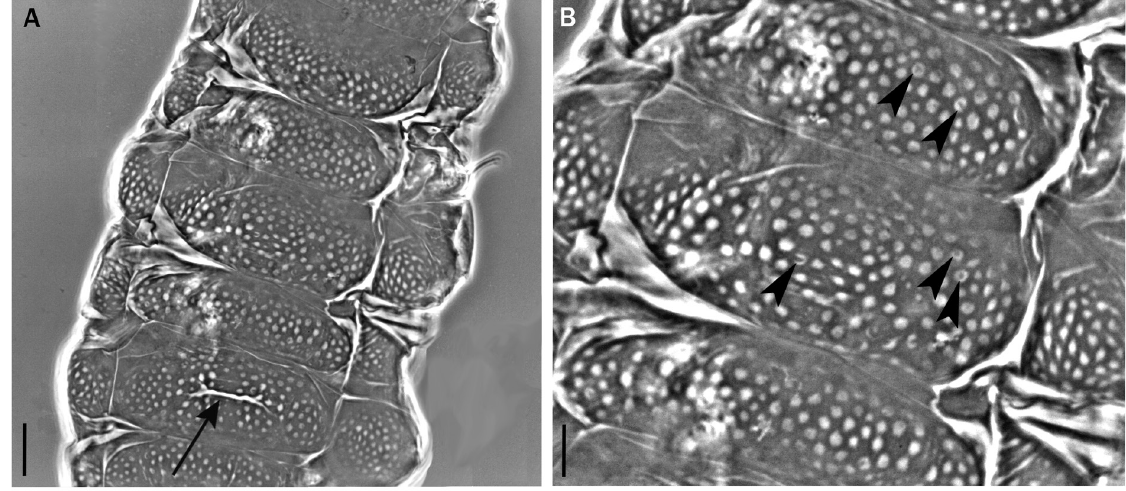
Fig. 6. Milnesium pelufforum sp. nov., paratype, young (slide No. 5898 (Pilato and Binda Collection)). Details of the cuticular ornamentation. A . General view of the dorsal cuticle showing several bands of sculptured cuticle and the cuticular groove at the level of legs III (arrow). B . Magnification of a portion of dorsal cuticle shown in A, better showing the cuticular dimples, some with evident internal structure (arrowheads), and others with more or less out of focus internal structure (the internal of the dimples is not bright, e.g., the dimples in the centre of the photo). Scale bars: A = 20 µm; B = 10